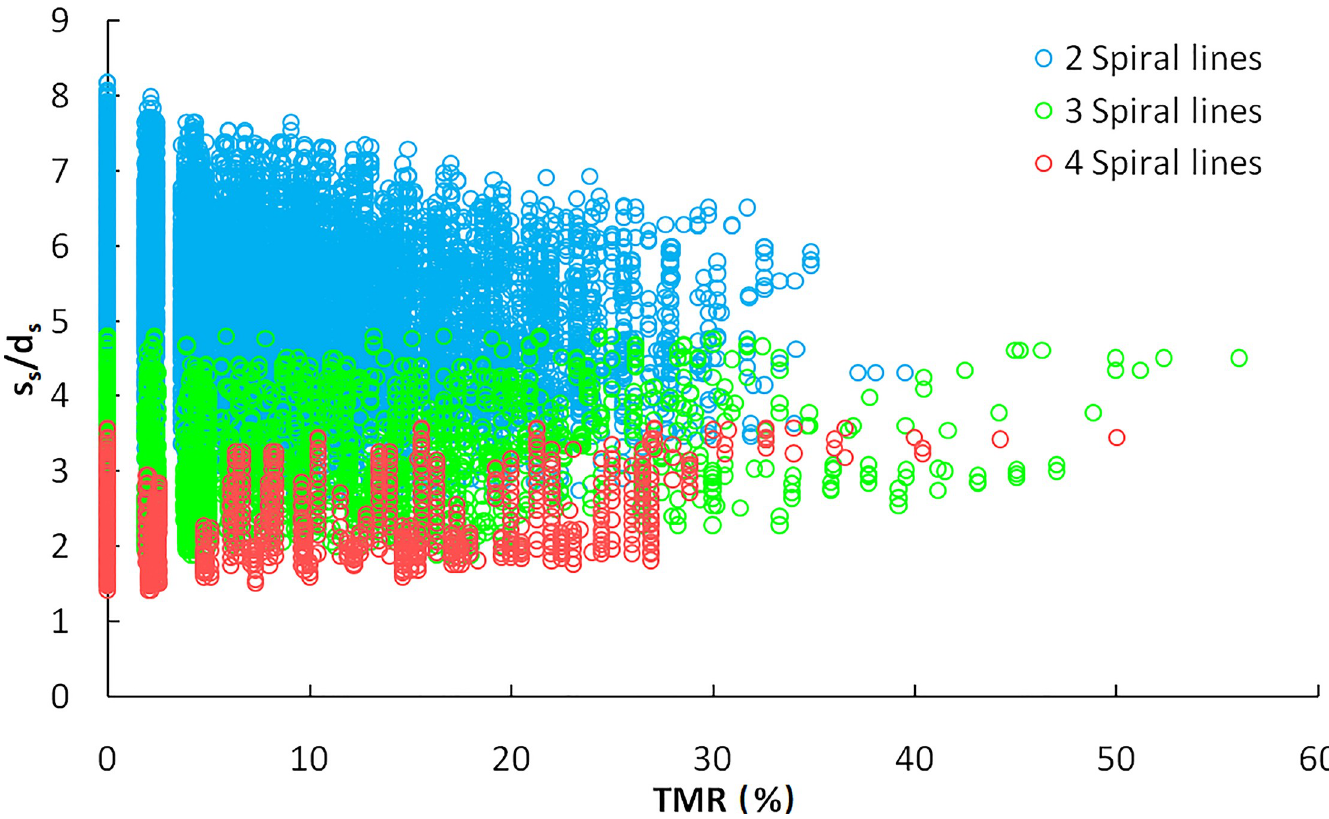
Fig 9. The relationship between TMR and s s /d s